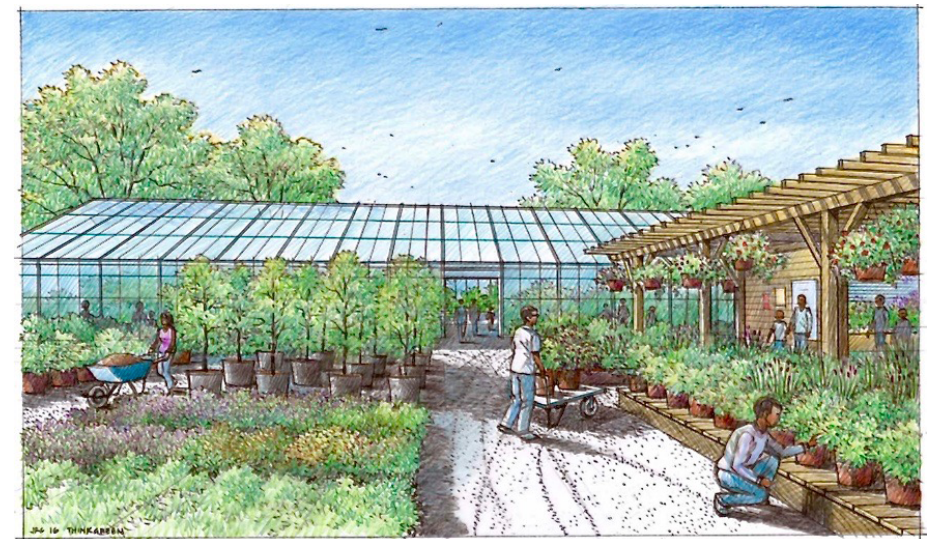
Figure 7. Vine and Willard vacant lots site rendering. Source: ThinkGreen,